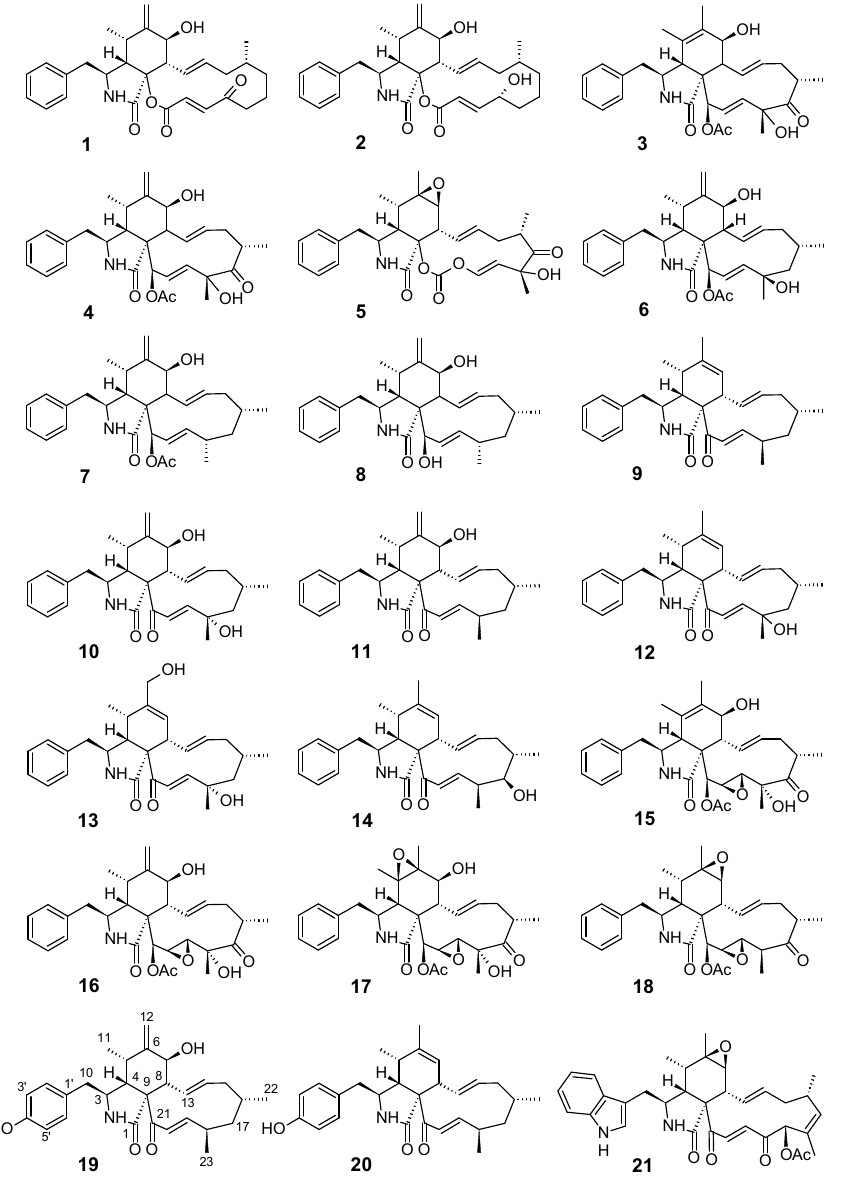
Figure 1. Chemical structures of the cytochalasins that were tested and isolated in the present study. For details of individual molecules see Table 1.